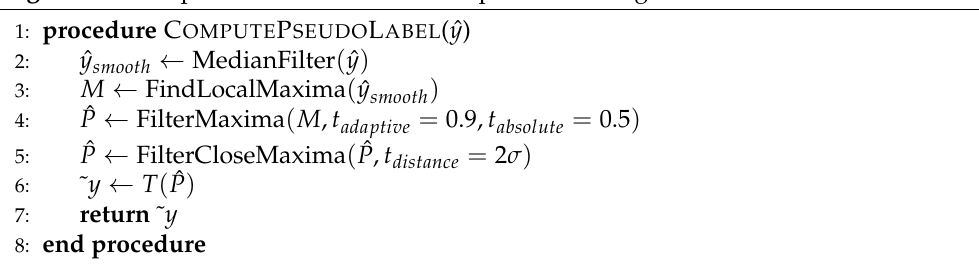
Algorithm 1 Proposed selective confidence